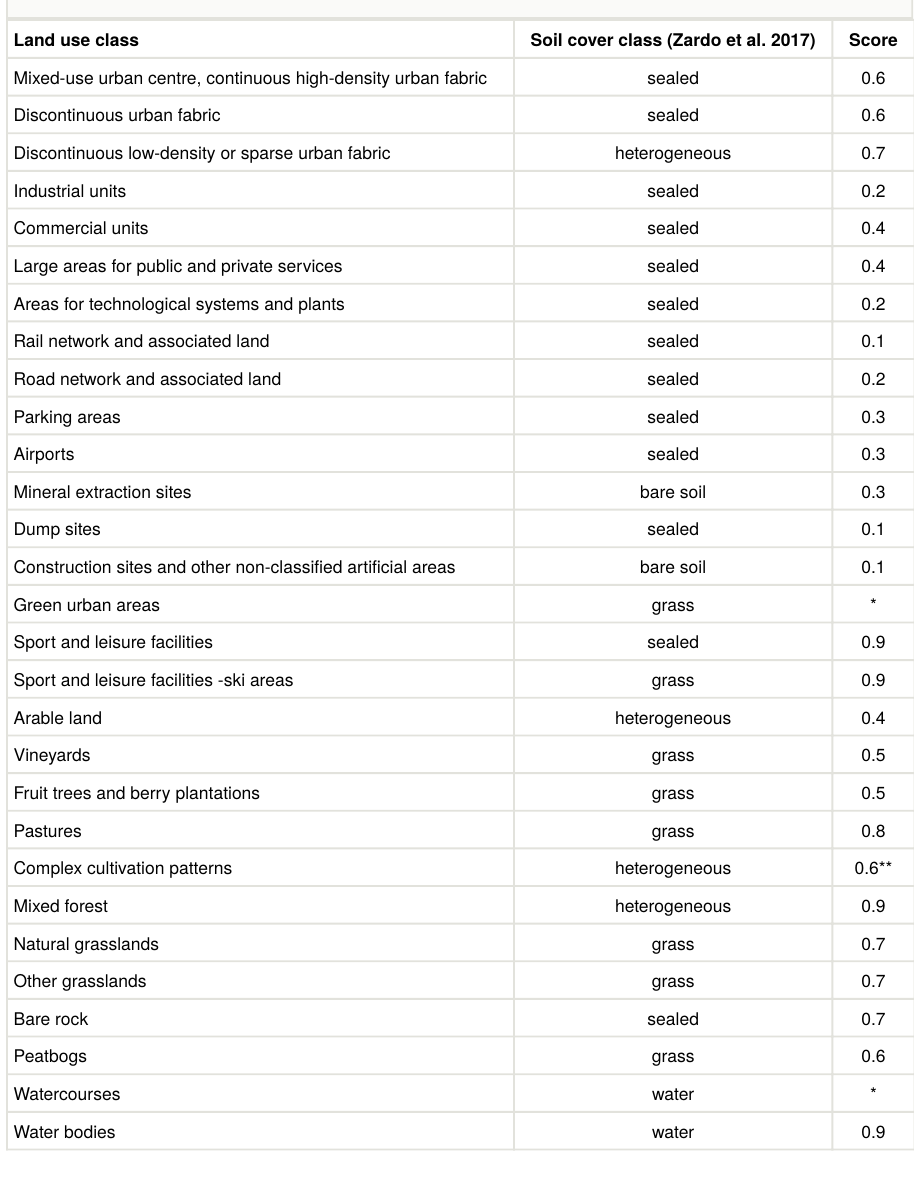
Table 2. Land use classes of the municipal map (Comune di Trento 2017), respective class of soil cover assigned for the cooling assessment and score resulting from the expert consultation about recreation. * Green urban areas and watercourses are included in other components of the ESTIMAP-recreation model, hence they are not assigned a score in the land use component. ** A score of 0.7 was assigned to